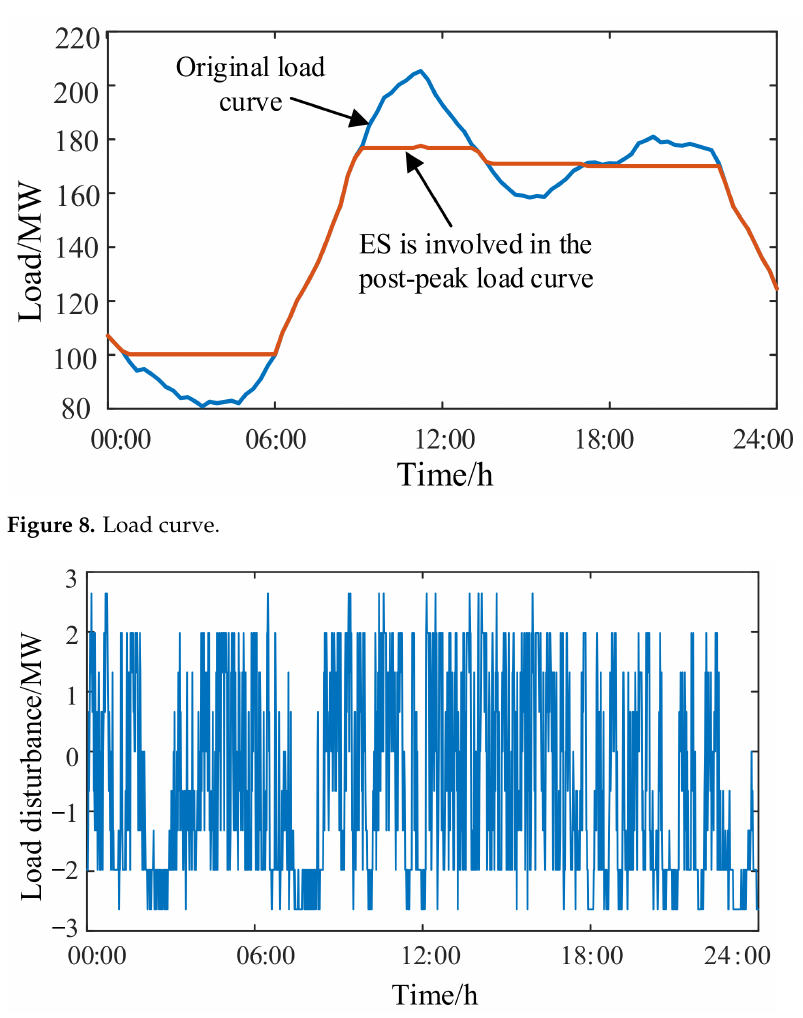
Figure 9. Load disturbance